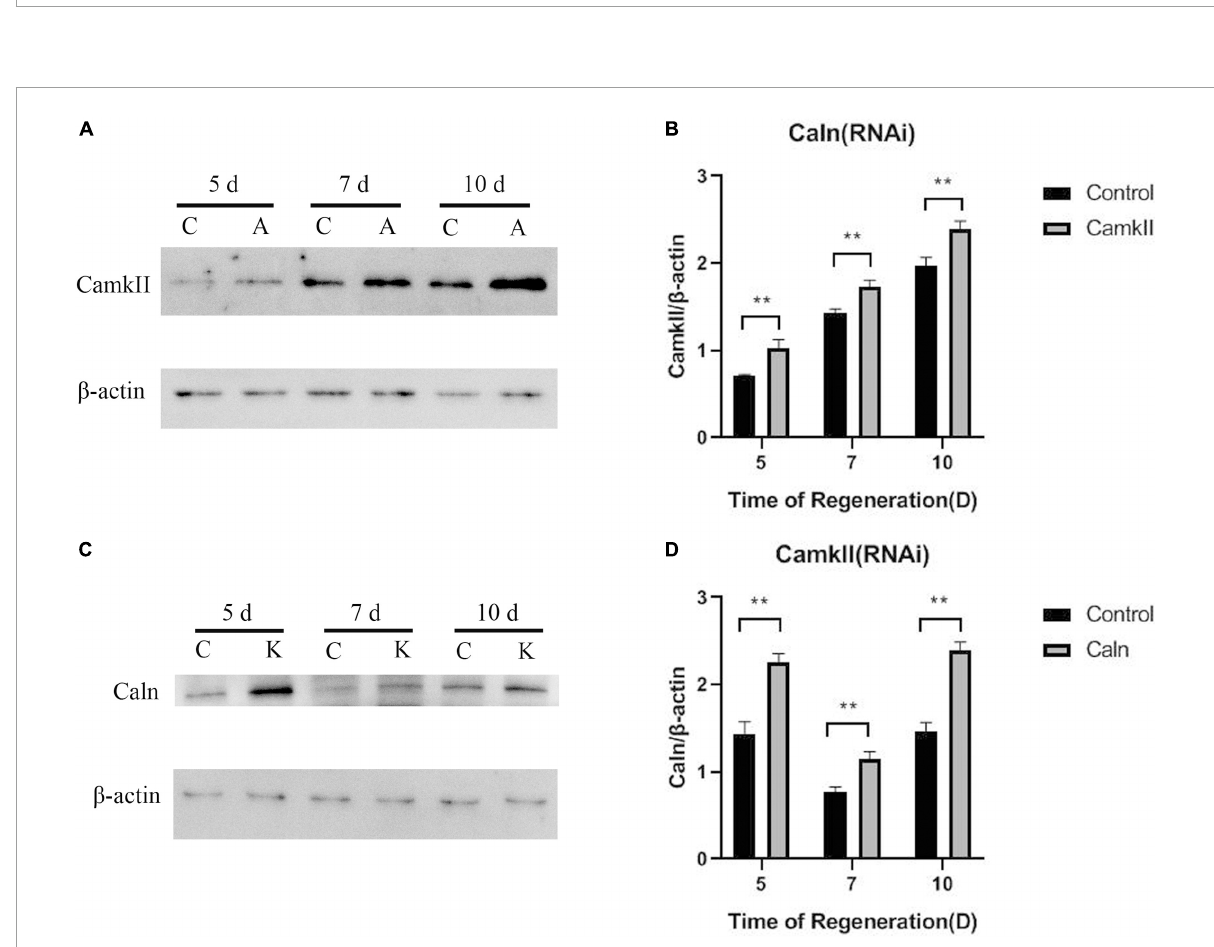
FIGURE2 Regulatory relationship between DjCaln and DjCamkII protein during planarian head regeneration. (A,B) DjCamkII protein levels in DjCaln (RNAi) planarians at 5, 7, and 10 days during planarian head regeneration, n = 5. (C,D) DjCaln protein levels in DjCamkII (RNAi) planarians at 5, 7, and 10 days during planarian head regeneration, n = 5, ** P < 0.01. C, control; A, DjCaln (RNAi); K, DjCamkII